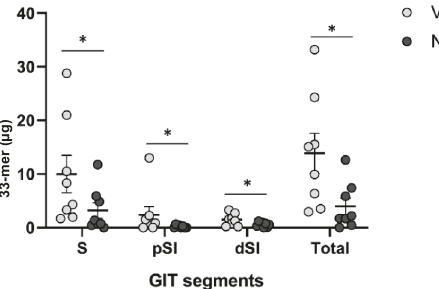
Fig. 4 | Analysis of neprosin activity against gliadin in vivo. Amount of 33-mer ( μ g) in the total contents of the stomach (S), proximal small intestine (pSI) and distal small intestine (dSI) of mice receiving neprosin zymogen (N) or vehicle (V) prior to a bolus of gliadin. Results are means ± SEM ( n =8 animals per group). Statisticalsigni fi cancewasdeterminedbyaone-sided F-test(* p <0.05,N vs B).The p valueswere0.048(S),0.049(pSI),0.026(dSI)and0.021(Total).Relevantsource data are provided as a Source Data fi